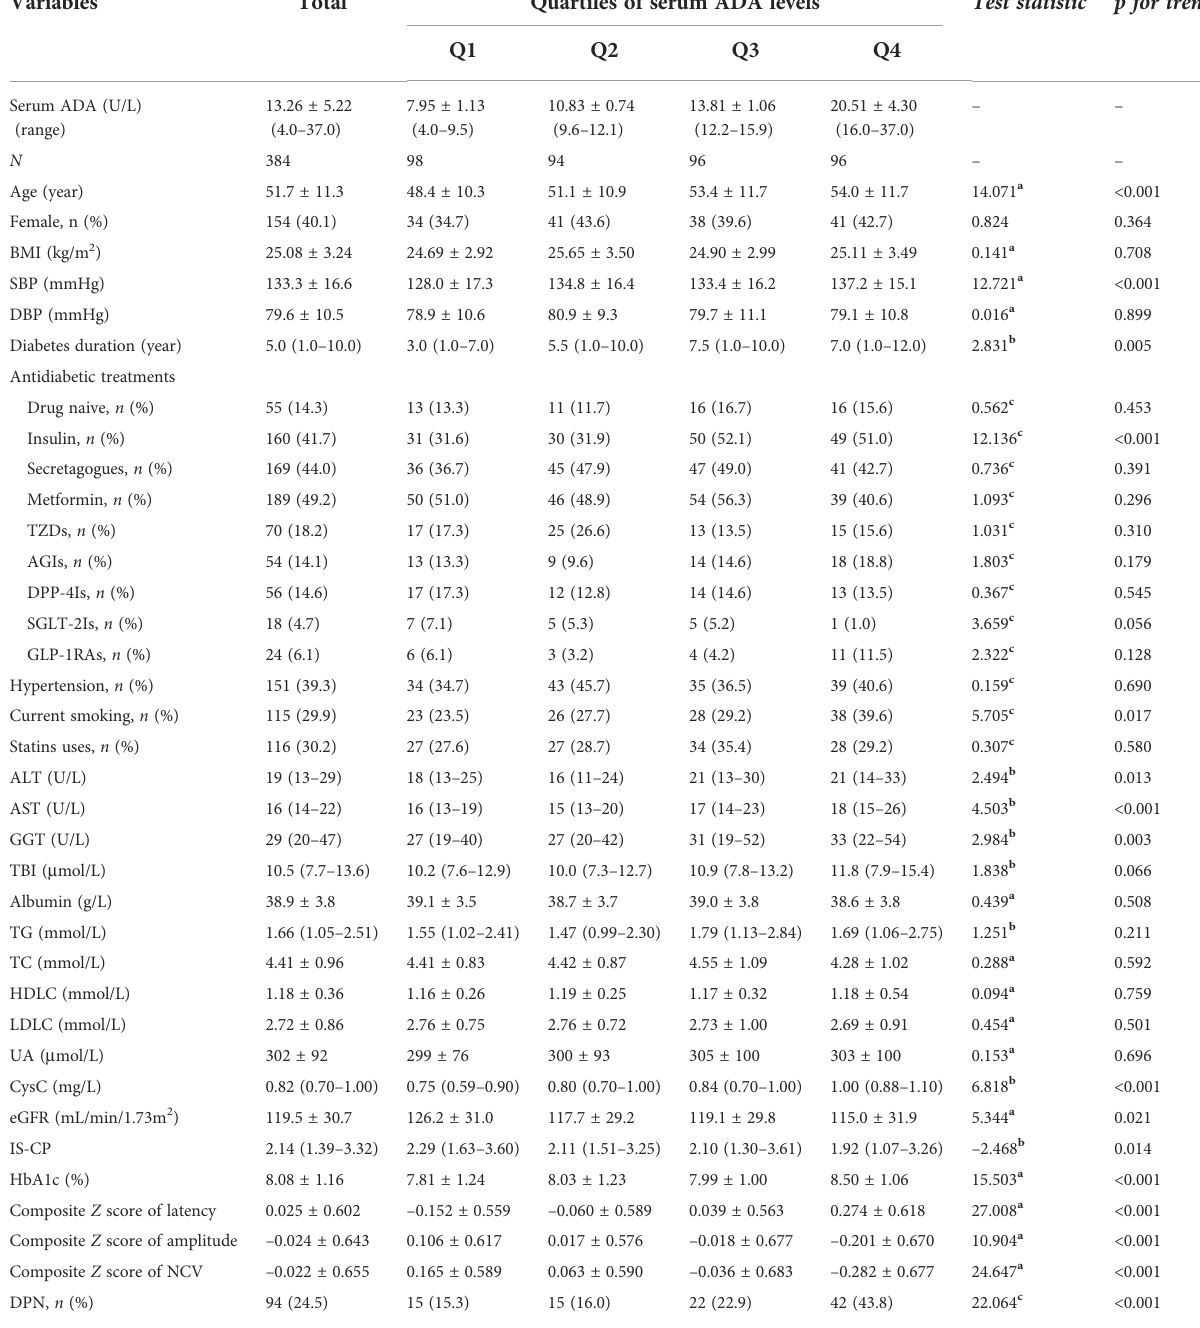
TABLE 1 Clinical features of the recruited